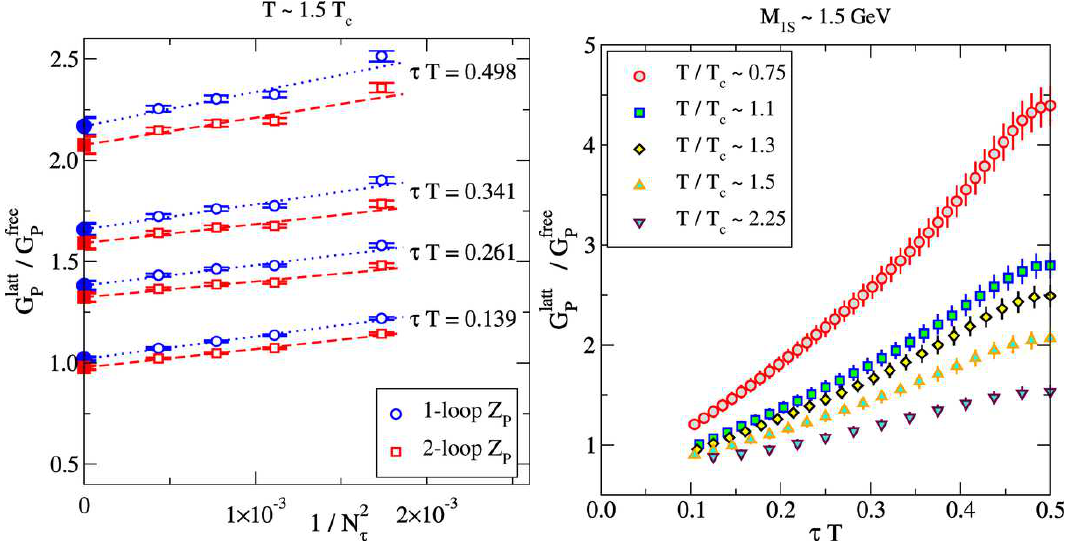
Figure 3 . Left: Examples of continuum extrapolations at T on 1-loop and 2-loop renormalization factors and a fit ansatz linear in 1 /N 2 We have also carried out fits quadratic in 1 /N 2 finest lattices; the variations are of the same order as the differences from using 1-loop and 2-loop renormalization factors, which we then adopt as our estimate of systematic uncertainties. Right: Continuum-extrapolated correlators. The uncertainties have been obtained by adding together, in quadrature, statistical errors and systematic uncertainties from the difference of using 1-loop and 2-loop renormalization